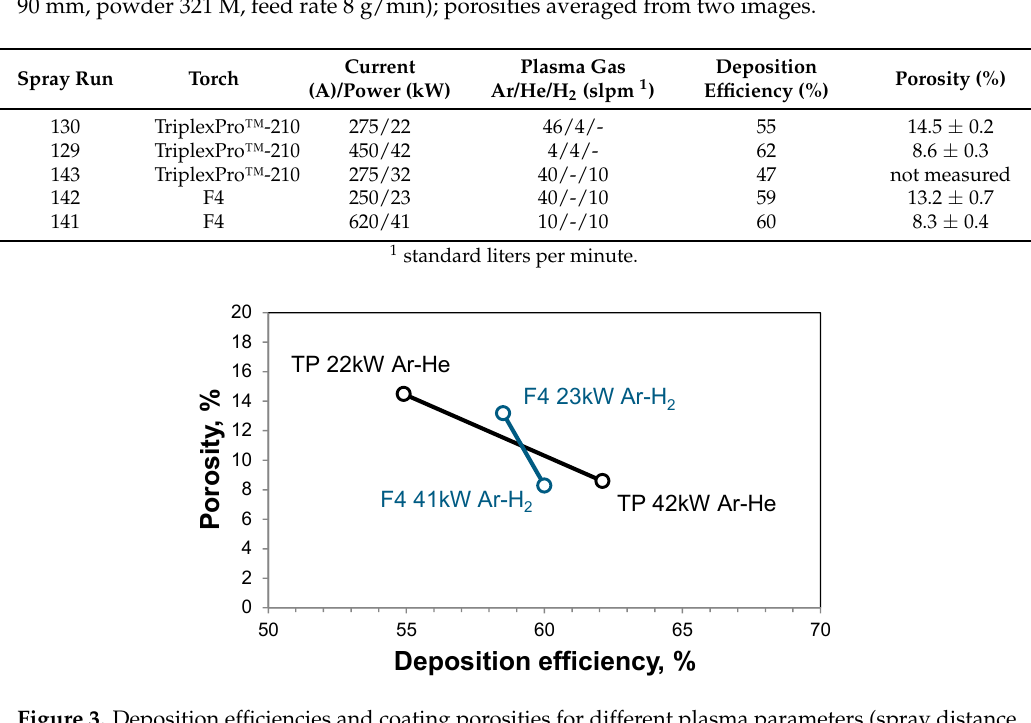
Figure 3. Deposition efficiencies and coating porosities for different plasma parameters (spray distance 90 mm, powder 321 M, feed rate 8 g/min.); porosities averaged from two images.